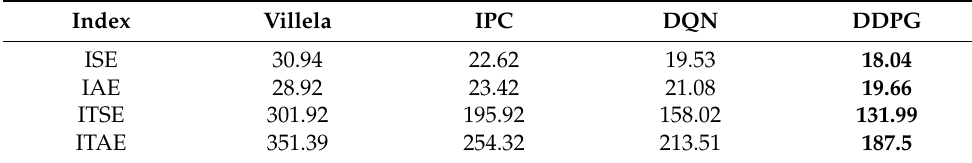
Table 4. Performance indices for the environment without obstacles.